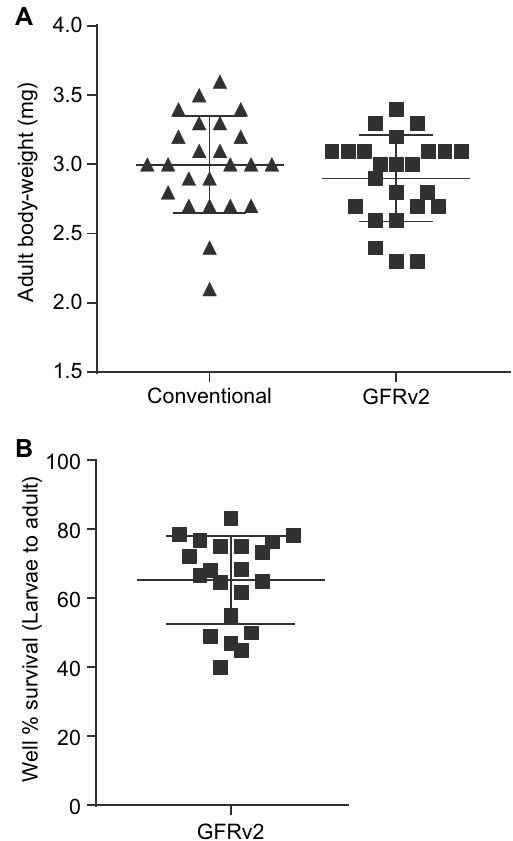
Figure 3. Survival and size of Nasonia germ-free adult females. ( A ) One-day-old and germ-free females reared on NRMv3 with GFRv2, and females reared conventionally. Body-weight was not significantly different between germ-free and conventional rearing (Mann–Whitney U test, p > 0.05). Vertical bars with caps represent the standard deviation from the mean. ( B ) The proportion of larval to adult survival in the